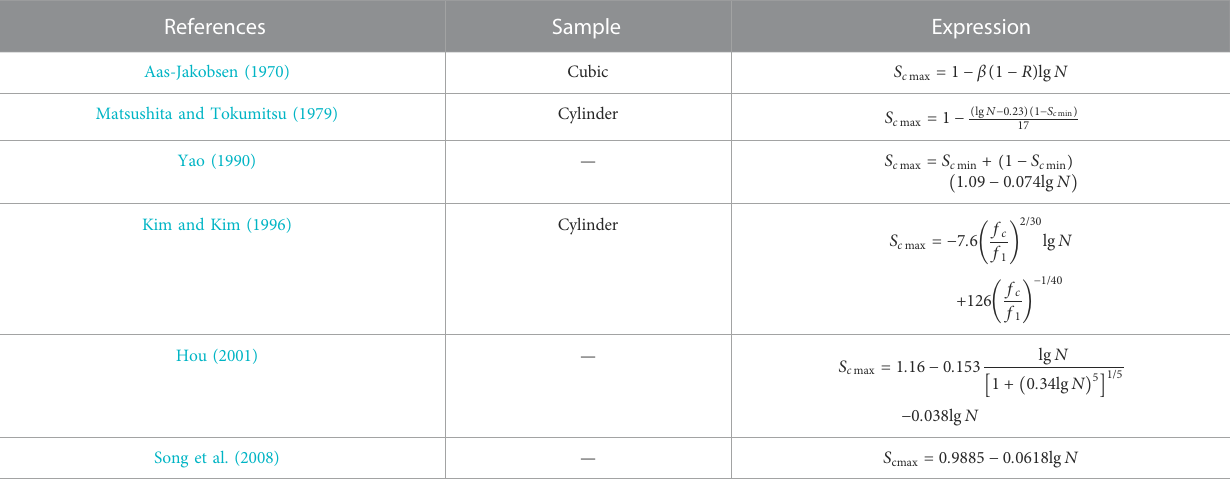
TABLE 1 Arrangement of fatigue equations of concrete under compression condition.